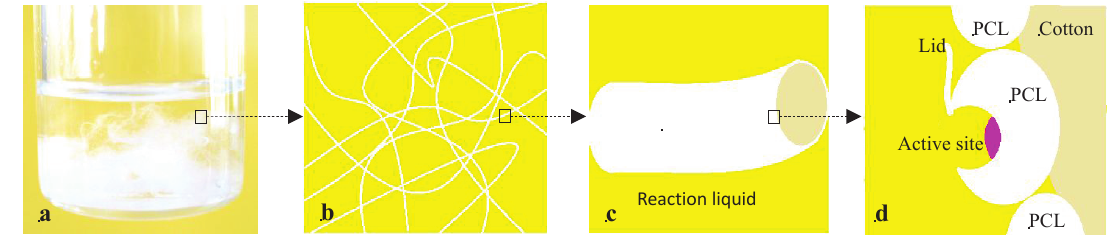
Figure 1: The partial picture of cotton-PCL bioreactor (a) and the structural sketches of locally enlarged cotton filaments (b), fiber segment (c) and cotton-PCL